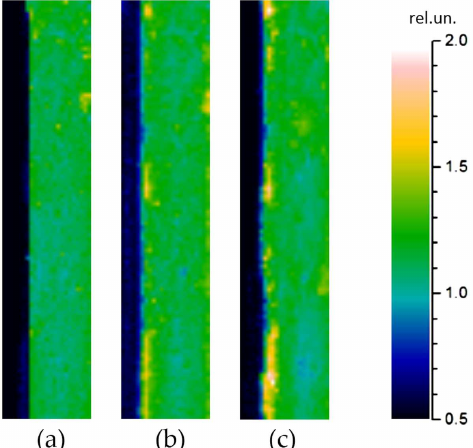
Figure 6. The PBD images of the area near a solder joint of Ge−Solder−AlN structure. The image size